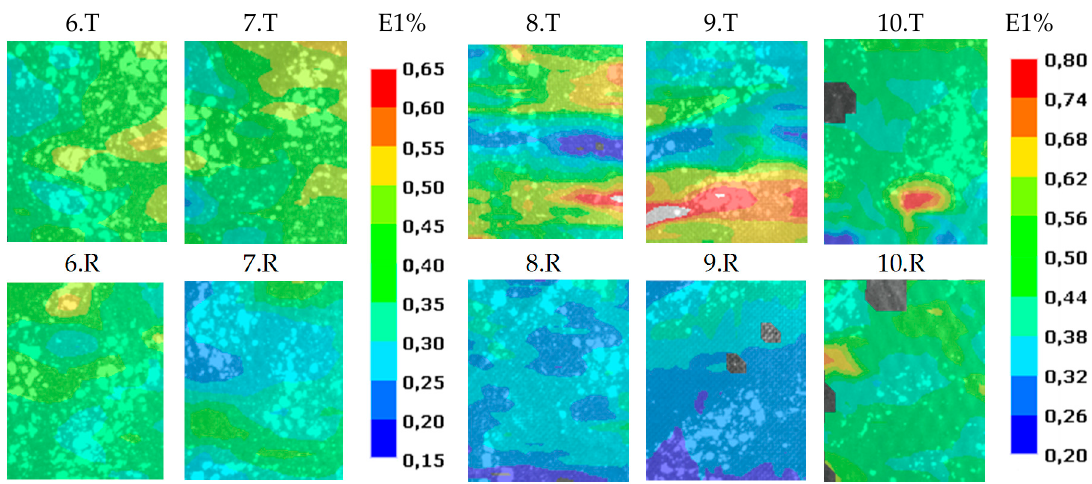
Figure 6. Comparison of longitudinal strains of specimens 6 – 10. during the tensile test.